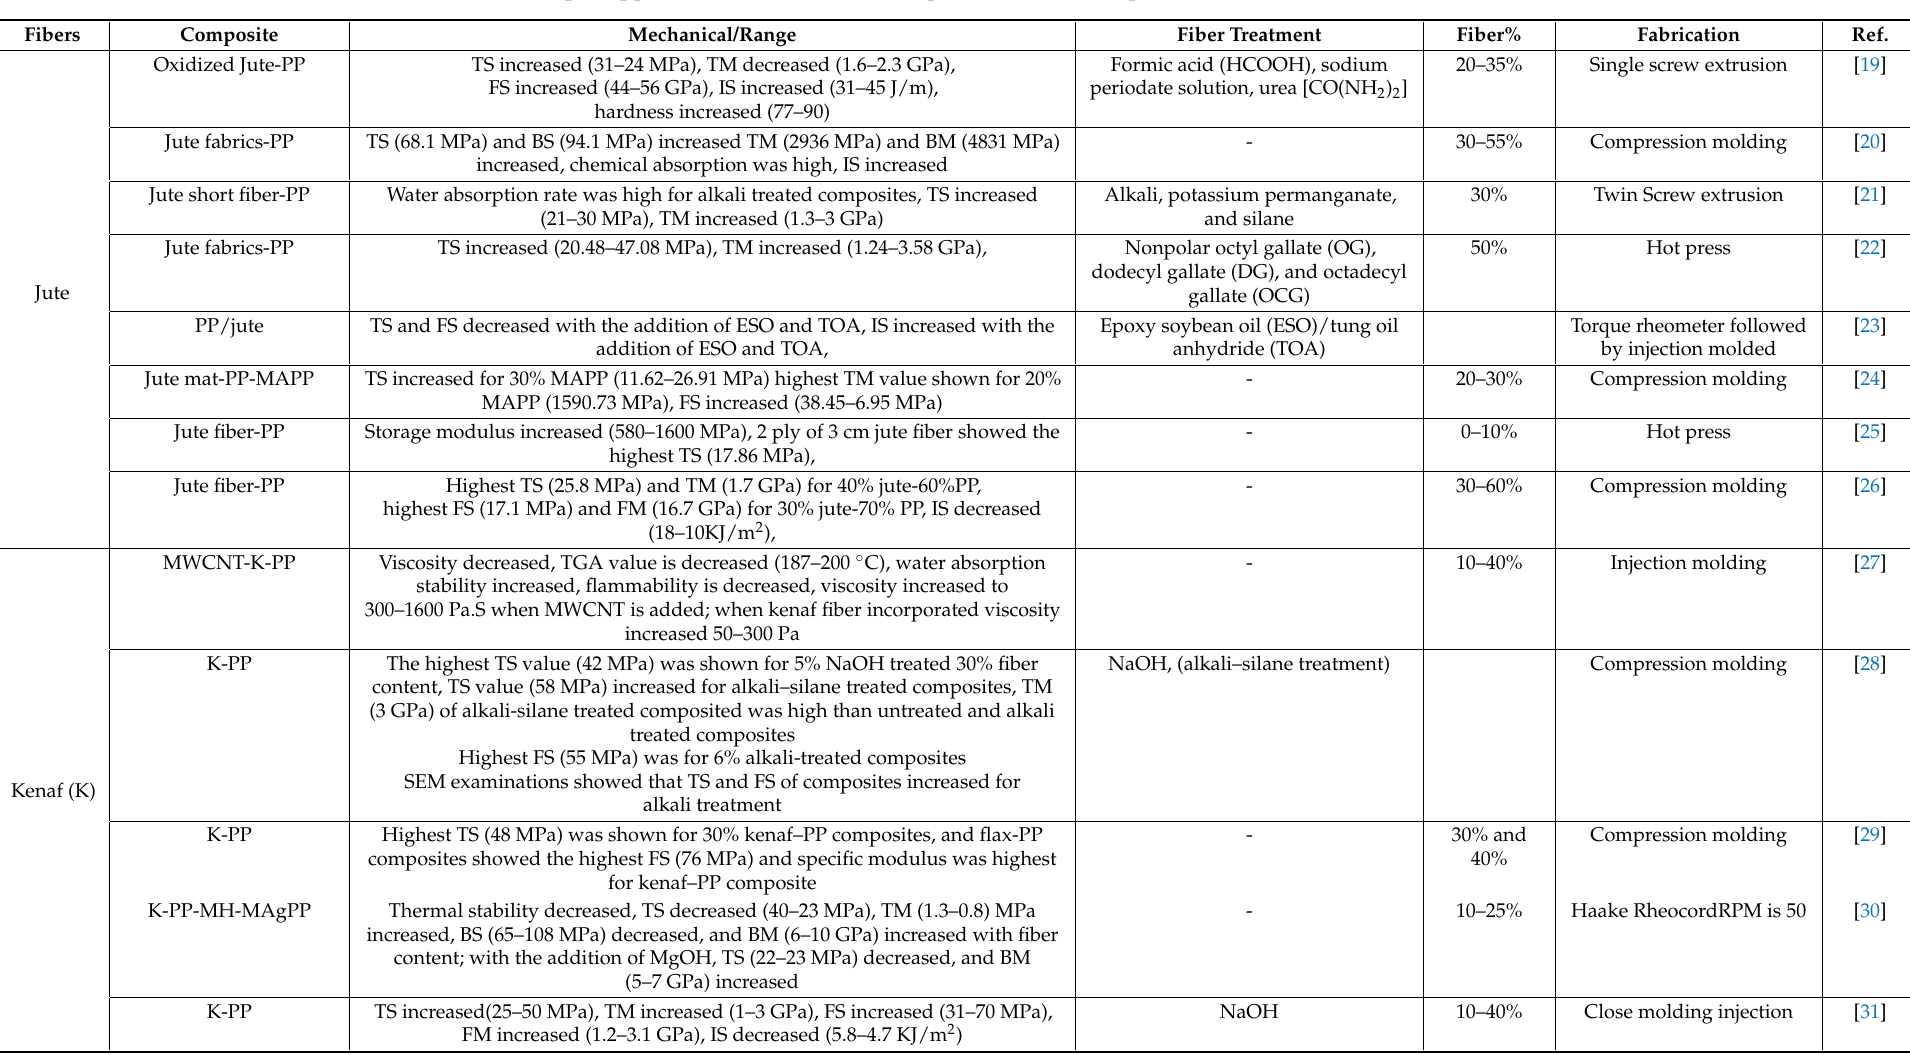
Table 1. Jute, kenaf, and pineapple leaf fiber characterization parameter with composite fabrication